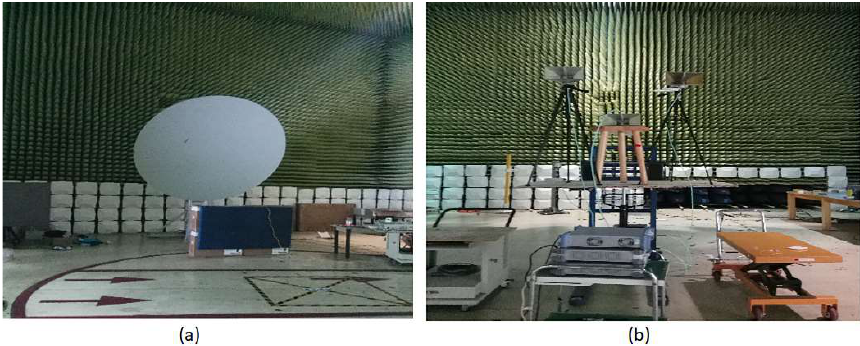
Figure 15. Settings of the segmentation experiment. ( a ) reflective surface; ( b ) horn antennas.